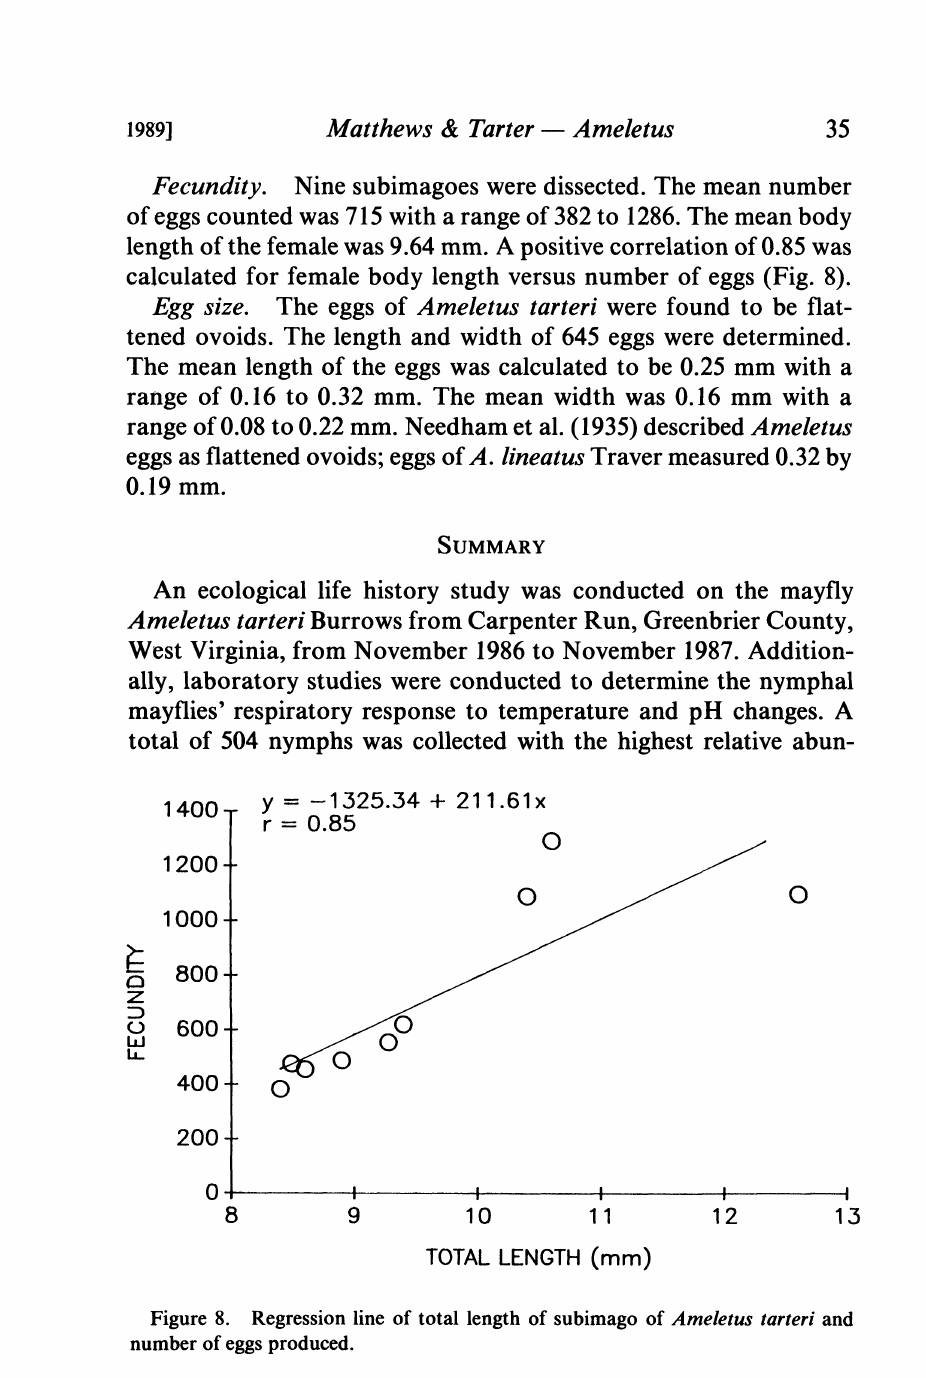
Figure 8. Regression line of total length of subimago of Ameletus tarteri and number of eggs